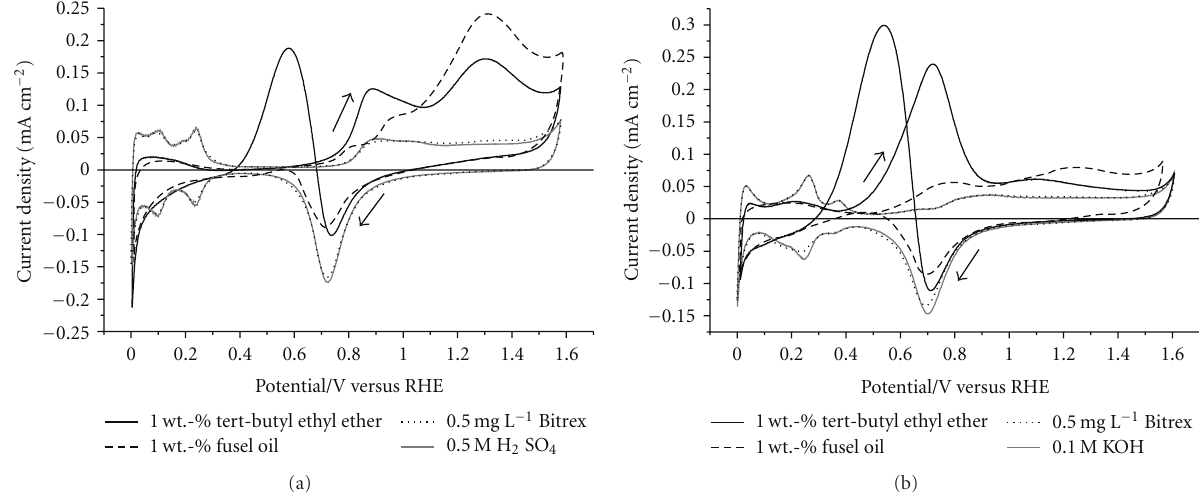
Figure 2: Electrochemical behaviour of potential denaturing agents in 0.5M H 2 SO 4 (a) and 0.1 M KOH (b). 1wt.-% ETBE (line), 1wt.-% fusel oil (dashed), 0.5 mgL − 1 Bitrex (dotted), and background (grey line). Scan rate 50 mVs − 1